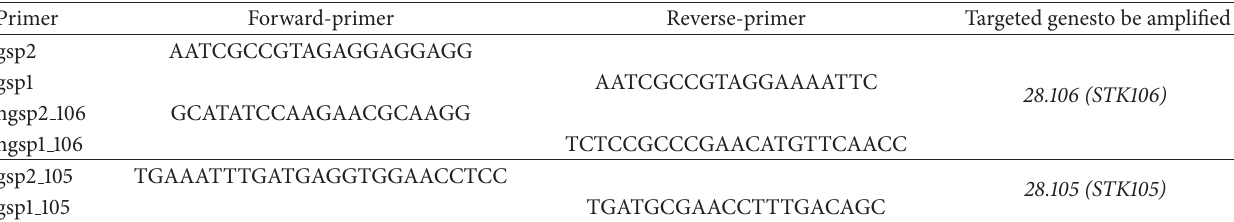
Table 1: Primer sequence used in RACE-PCR and